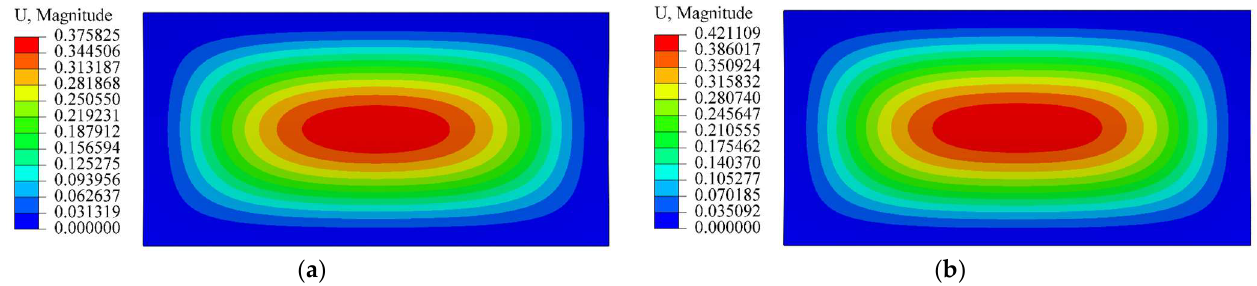
Figure 9. Displacement nephogram when Ra 2 / t = 1 and q = 25 Kpa. ( a ) E + / E − = 1; ( b ) E + / E − = 3/2.